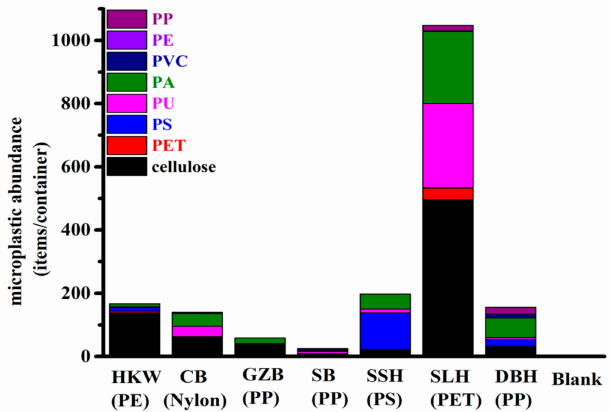
Figure 2. Microplastic abundance in take-out containers (items/container).